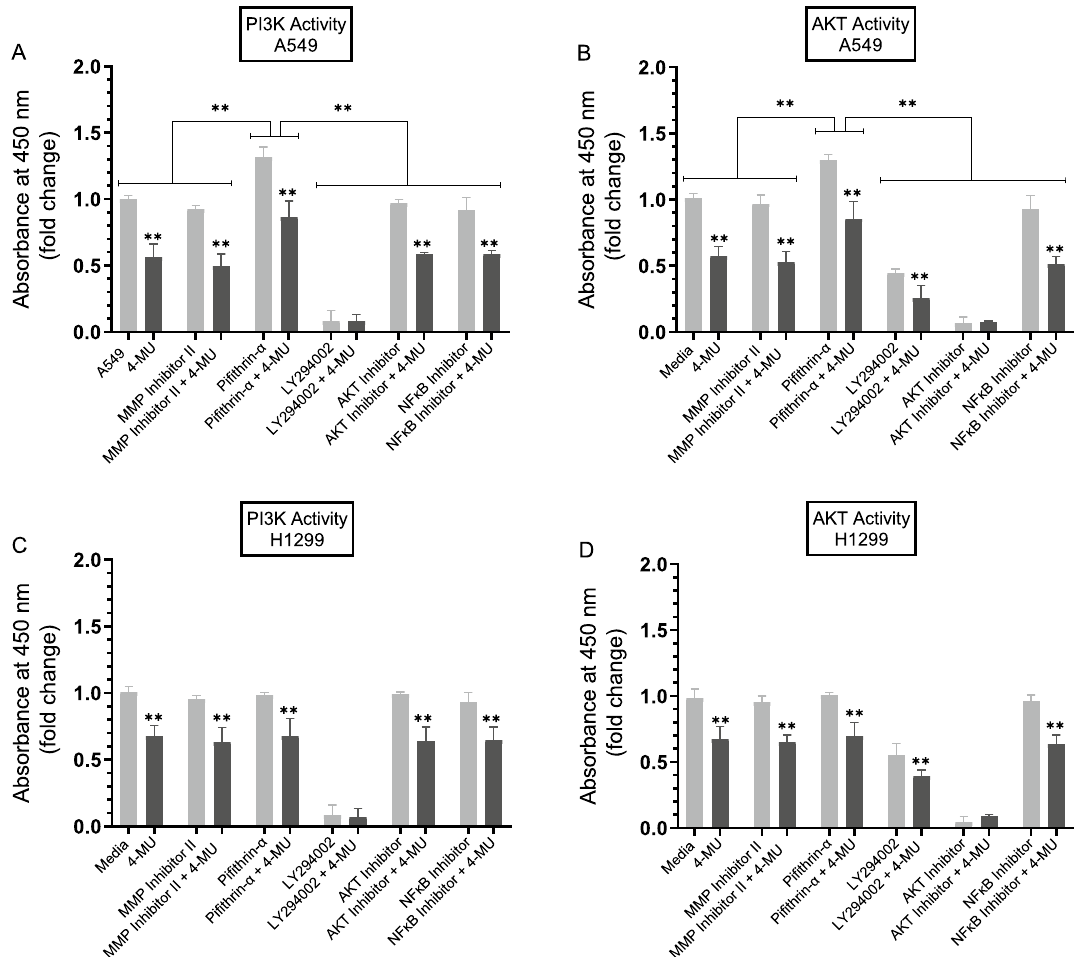
Figure 5. The activity of either PI3K or AKT is upregulated upon treatment of A549 cells with the p53 inhibitor, pifithrin-α. Cells (0.2 × 10 5 ) were grown in 10% FBS-supplemented media for 24 h. The following day, the cell monolayers were incubated in serum-free media for 24 h, then treated as indicated for 72 h with the inhibitors without or with 600 µM 4-MU. The PI3K activity was assayed by the Total In-Cell ELISA Kit and the AKT activity was measured on the same amount of protein (3 µL of 600 µg/mL total protein) of cell lysate as described in the “Methods” section. Data from five independent assays, each carried out in triplicate, were quantitated, averaged, normalized, and expressed as fold change relative to cells not treated with 4-MU using the GraphPad 8.4.3 software. The graphs summarize the results expressed as means ± SD (n = 5). Asterisks (*) indicate a statistically significant difference from the corresponding samples without 4-MU treatment for each cell line, Mann–Whitney test, while the absence of asterisks indicates no significance. Statistical differences between different groups were analyzed by an ordinary one-way analysis of variance (ANOVA) followed by Tukey’s post-hoc multiple comparison test. * p < 0.05, ** p <